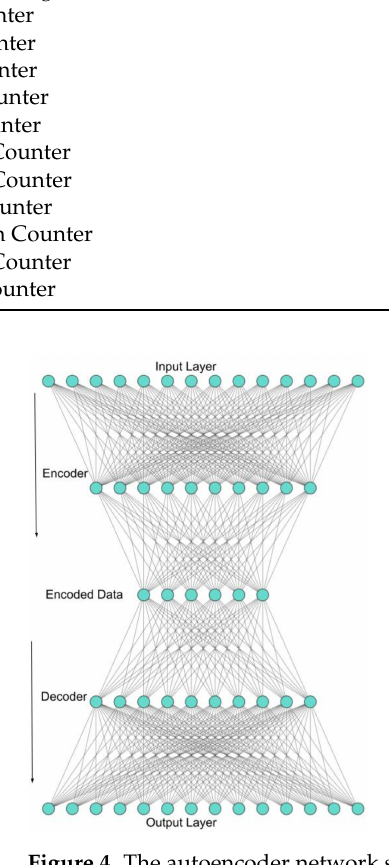
Figure 4. The autoencoder network